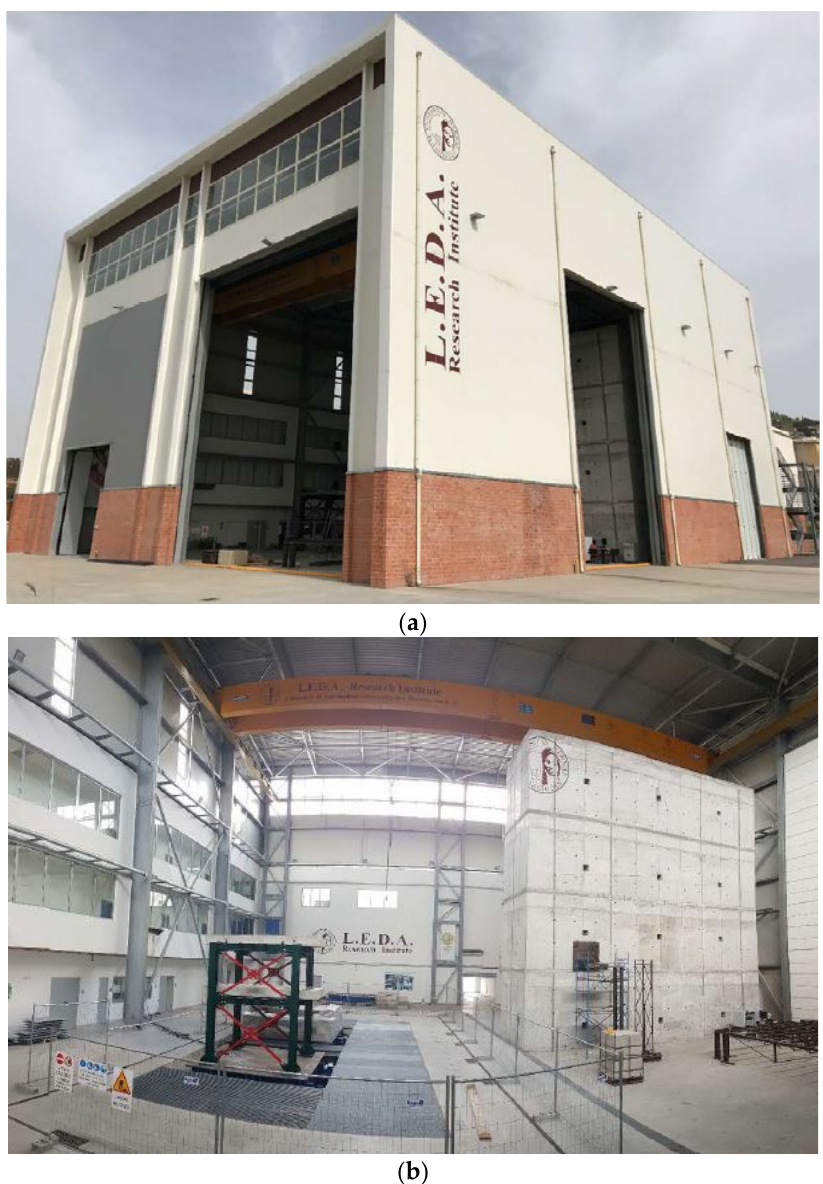
Figure 15. Laboratory of Earthquake Engineering and Dynamic Analysis (L.E.D.A.) of “Kore” University of Enna (Sicily, Italy): ( a ) external view; ( b ) internal view (From [62]).